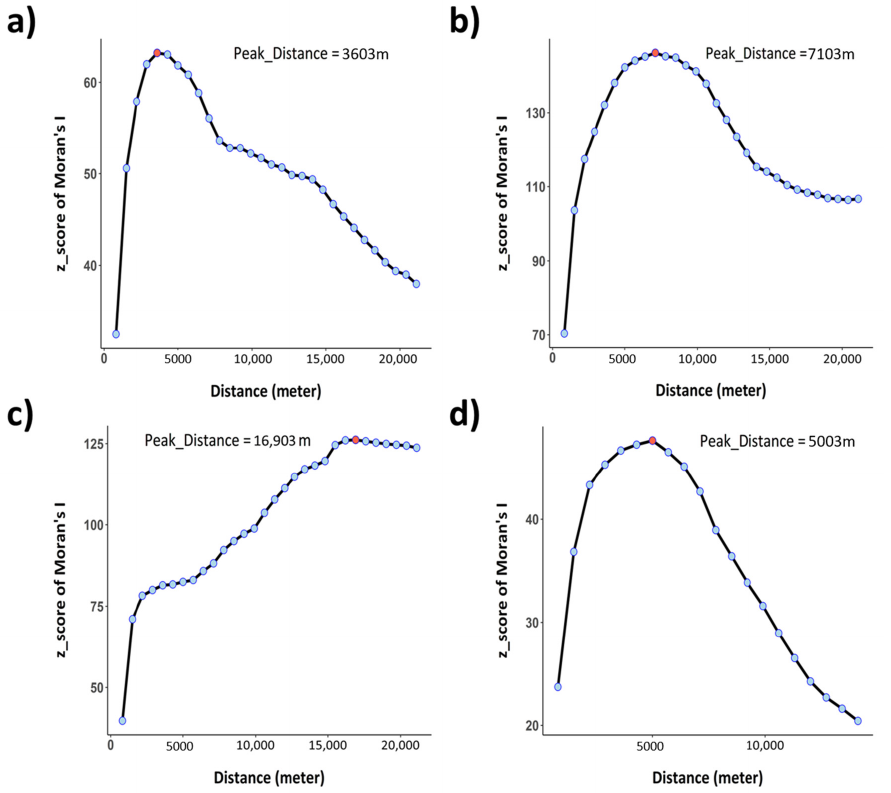
Figure 5. Z-score of Global Moran’s I by distance: ( a ) Jeollabuk-do (peak distance = 3603 m); ISPRS Int. J. Geo-Inf. 2021 , 10 , x FOR PEER REVIEW ( b ) Jellanam-do (peak distance = 7603 m); ( c ) Gyeongsangnam-do (peak distance=16,903 m); ( d ) Jeju- do (peak distance = 5003 m).